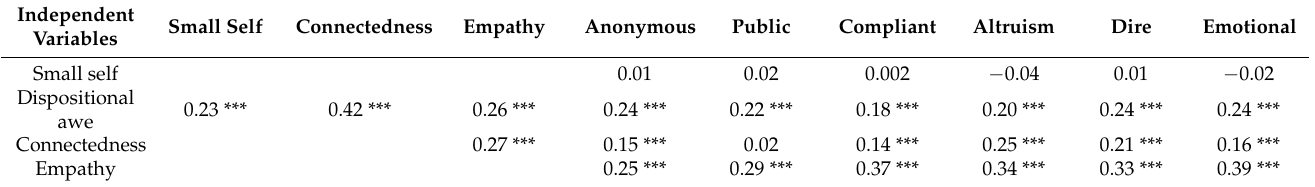
Table 2. The path analysis among the